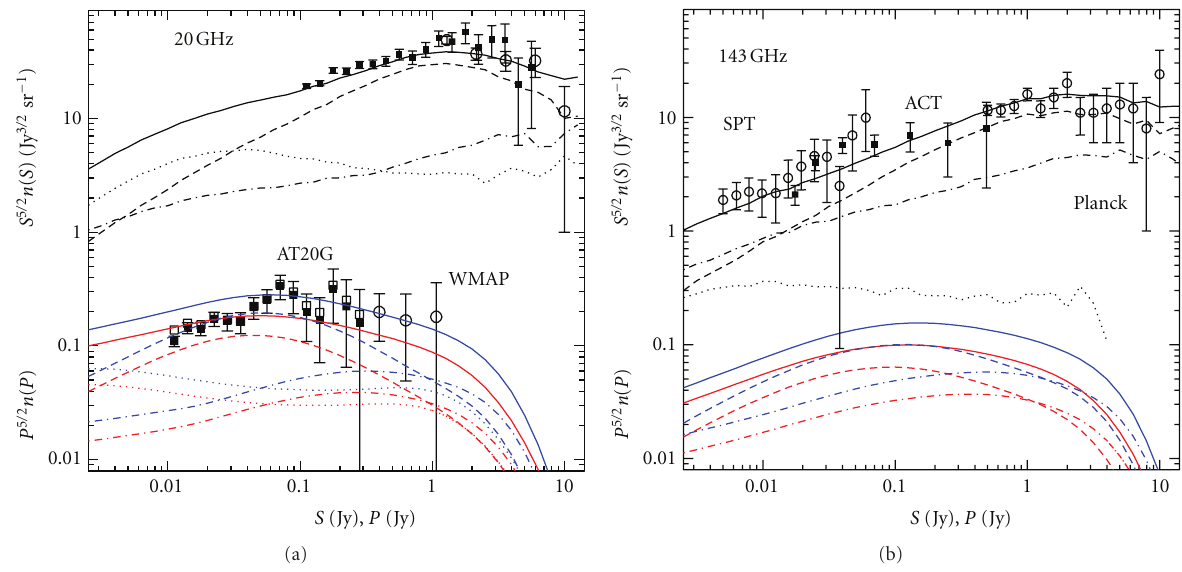
Figure 6: Normalized number counts at 20 (a) and at 143 GHz (b) in total intensity (upper curves and data points) and in polarized intensity (lower curves and data points; blue curves are for the more “conservative” case and red curves for the more “optimistic” case). Number counts are for the di ff erent source populations discussed in the text: solid lines represent total number counts; dotted lines are for steep-spectrum sources; long-dashed lines are for FSRQs; finally, dot-dashed lines are for BL Lacs. In (a), filled squares represent our current estimates from the AT20G subsample (empty squares include the contribution from sources without polarization detection; see Section 4.3) and empty circles are from WMAP 5-years data [55]. Data points in (b) are from published data